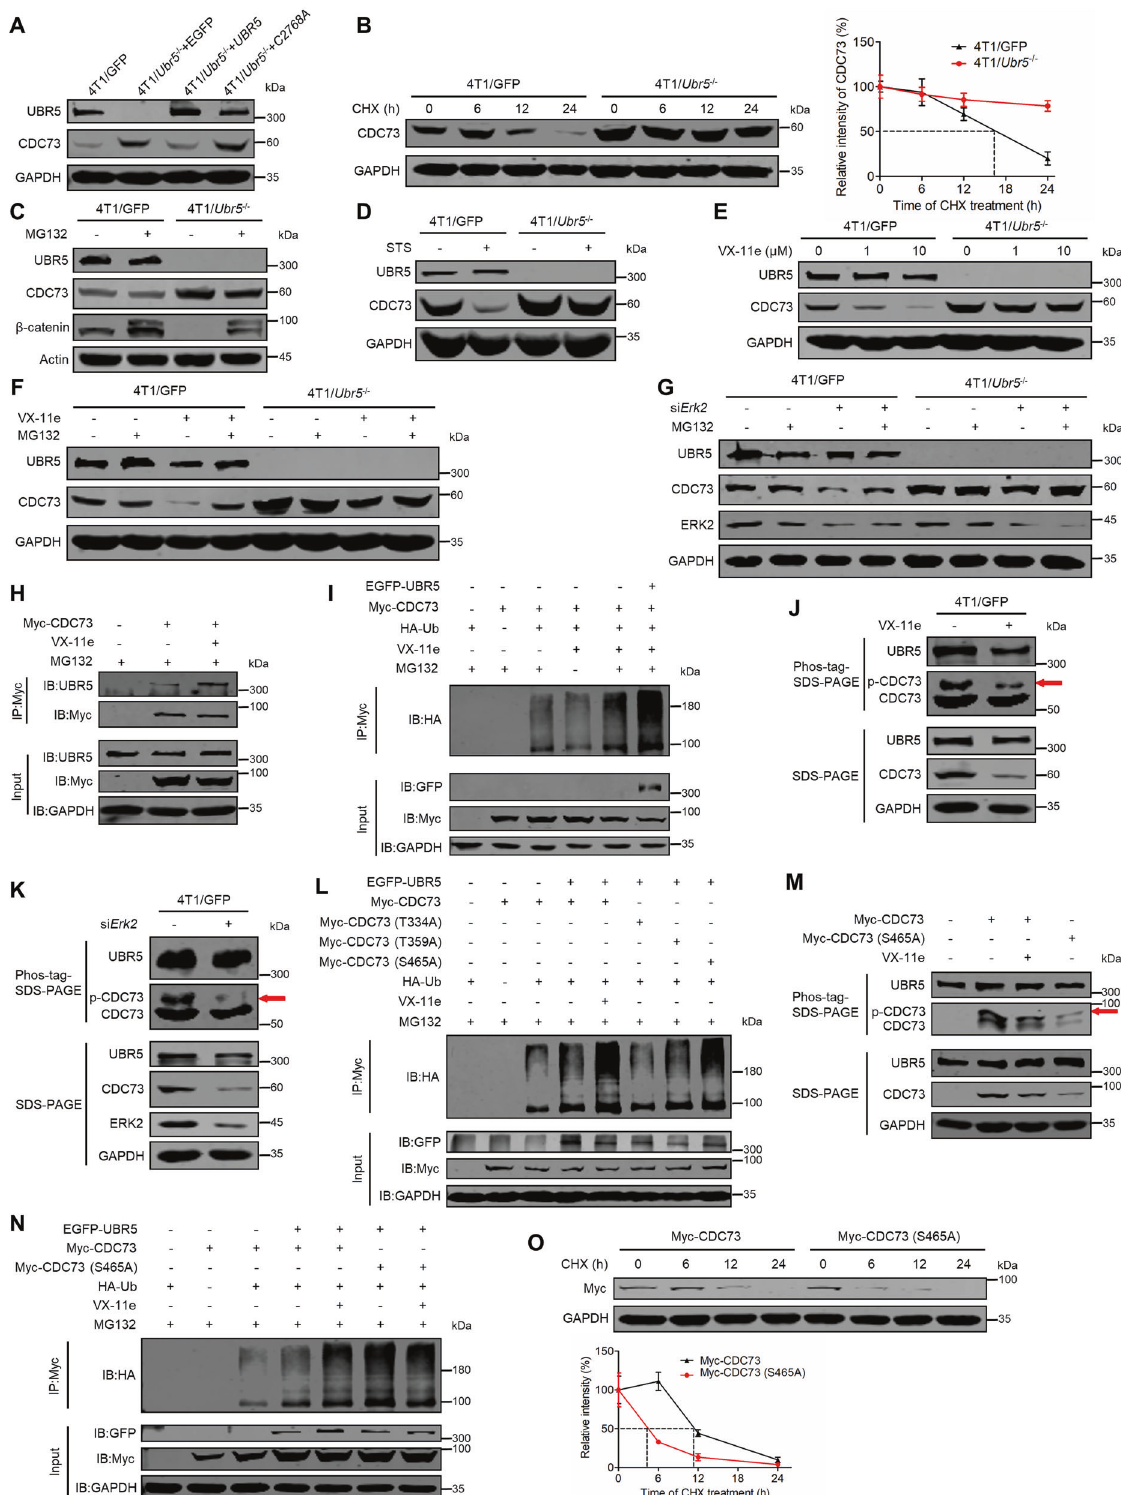
that all three mutants could reduce the ubiquitination of CDC73 (compare lanes 6-8 to lane 4), although K257R exhibited the maximum reduction among them. These data indicate that Lys 243 , Lys 247 and Lys 257 are all involved in CDC73 ’ s ubiquitina- tion and degradation by UBR5-mediated